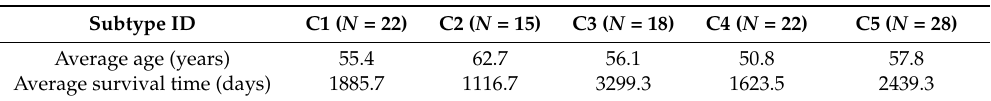
Table 4. The average initial diagnosis ages and survival times of patients in the identified subtype clusters in BIC cancer datasets.